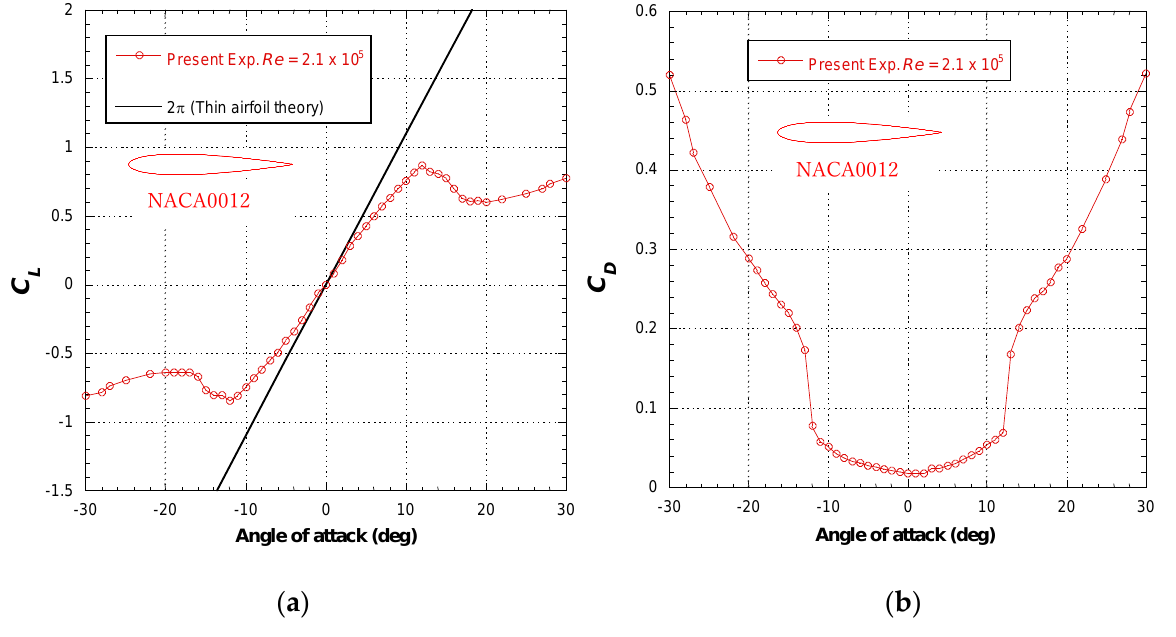
Figure 5. Results of single NACA0012 for balance measurement: ( a ) drag coefficient; ( b ) lift coefficient.